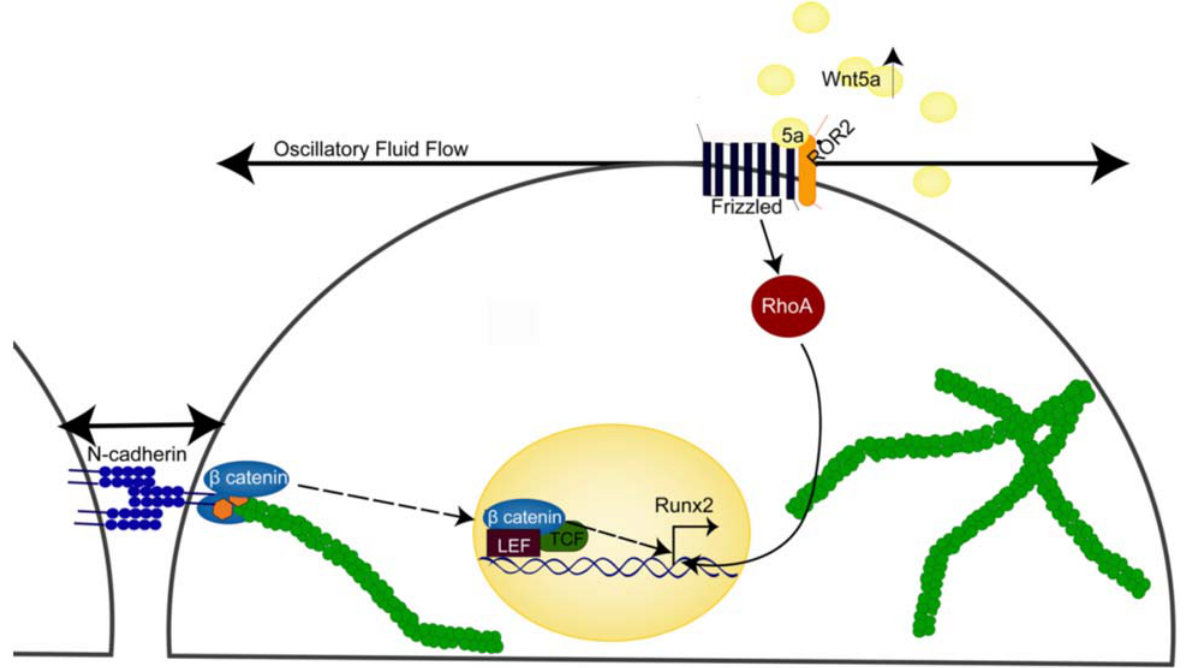
Figure 6. A schematic diagram of potential signaling mechanisms involved in mechanically stimulated osteogenic differentiation. Oscillatory fluid flow, a potent mechanical signal within the microenvironment of bone has the potential to regulate non-canonical Wnt5a and b - catenin signaling pathways in MSCs, both of which are essential for fluid flow induced osteogenic lineage commitment via Runx2 upregulation. Furthermore, Wnt5a signals through Ror2 to activate RhoA, a small GTPase that is necessary and sufficient for osteogenic differentiation. Finally, flow induced b -catenin signaling appears to be mediated by alterations in N-cadherin/ b -catenin association indicating that adherens junctions may be involved in the transduction of a mechanical signaling into a cell fate